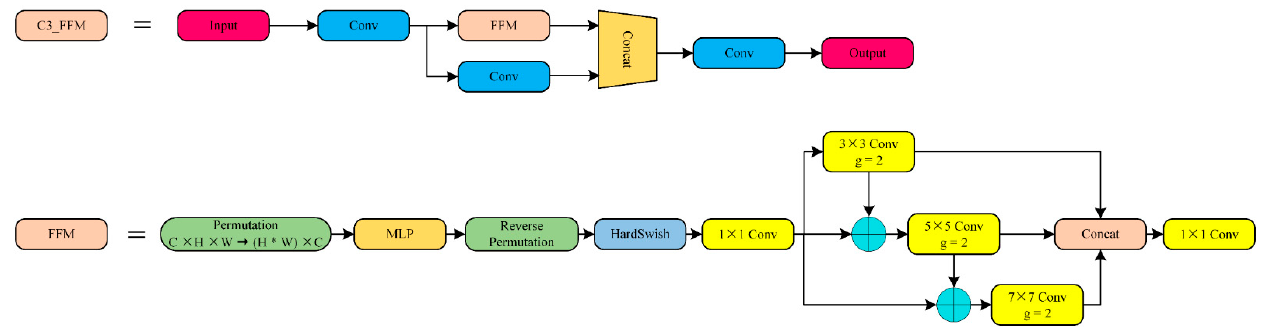
Figure 2. C3_FFM. The core of the Feature Fusion Module (FFM) is a layer ‐ by ‐ layer concatenated convolutional structure.